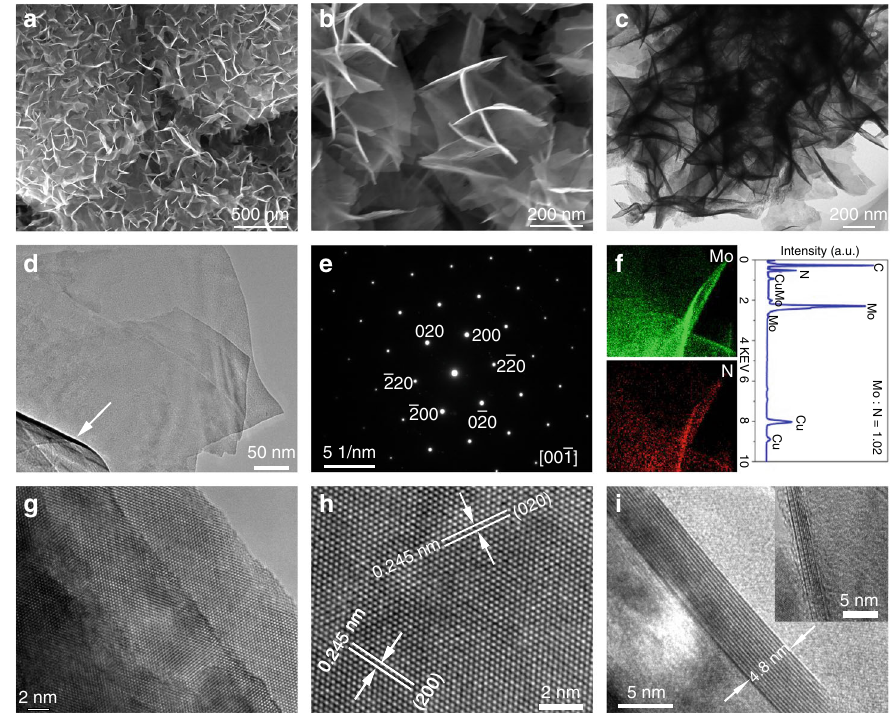
Fig. 2 Morphology and structure characterization of the δ − MoN nanosheets. a , b SEM images. c , d TEM images. e SAED pattern. f EDS spectrum and mapping. g – i HRTEM